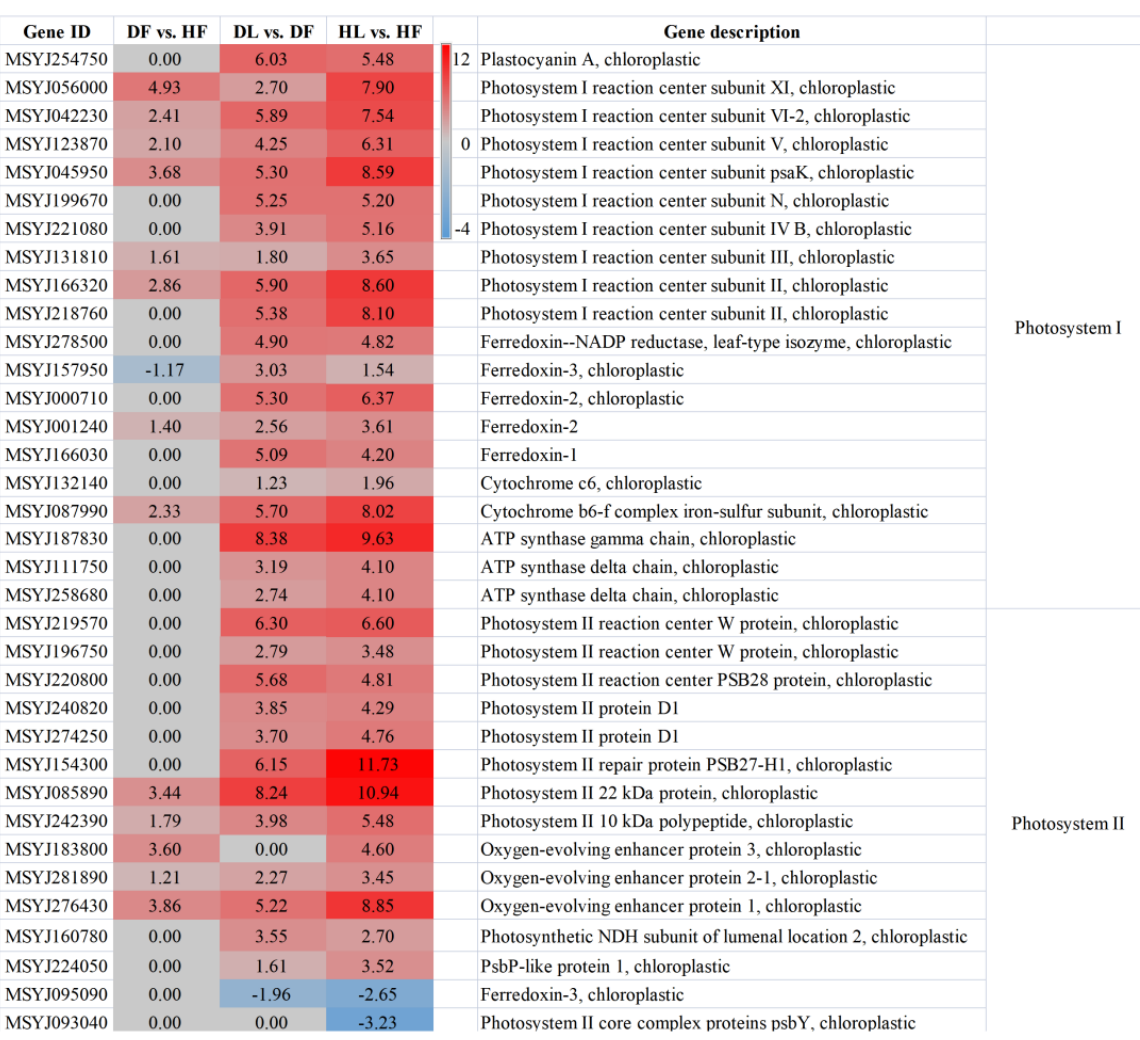
Figure 6. Log 2 Fold change cluster diagram of the differentially expressed genes in the photosynthesis pathway. DF, diseased fruit pith. DL, diseased leaf. HF, healthy fruit pith. HL, healthy leaf. The color bar represents a range of Log 2 Fold change values.